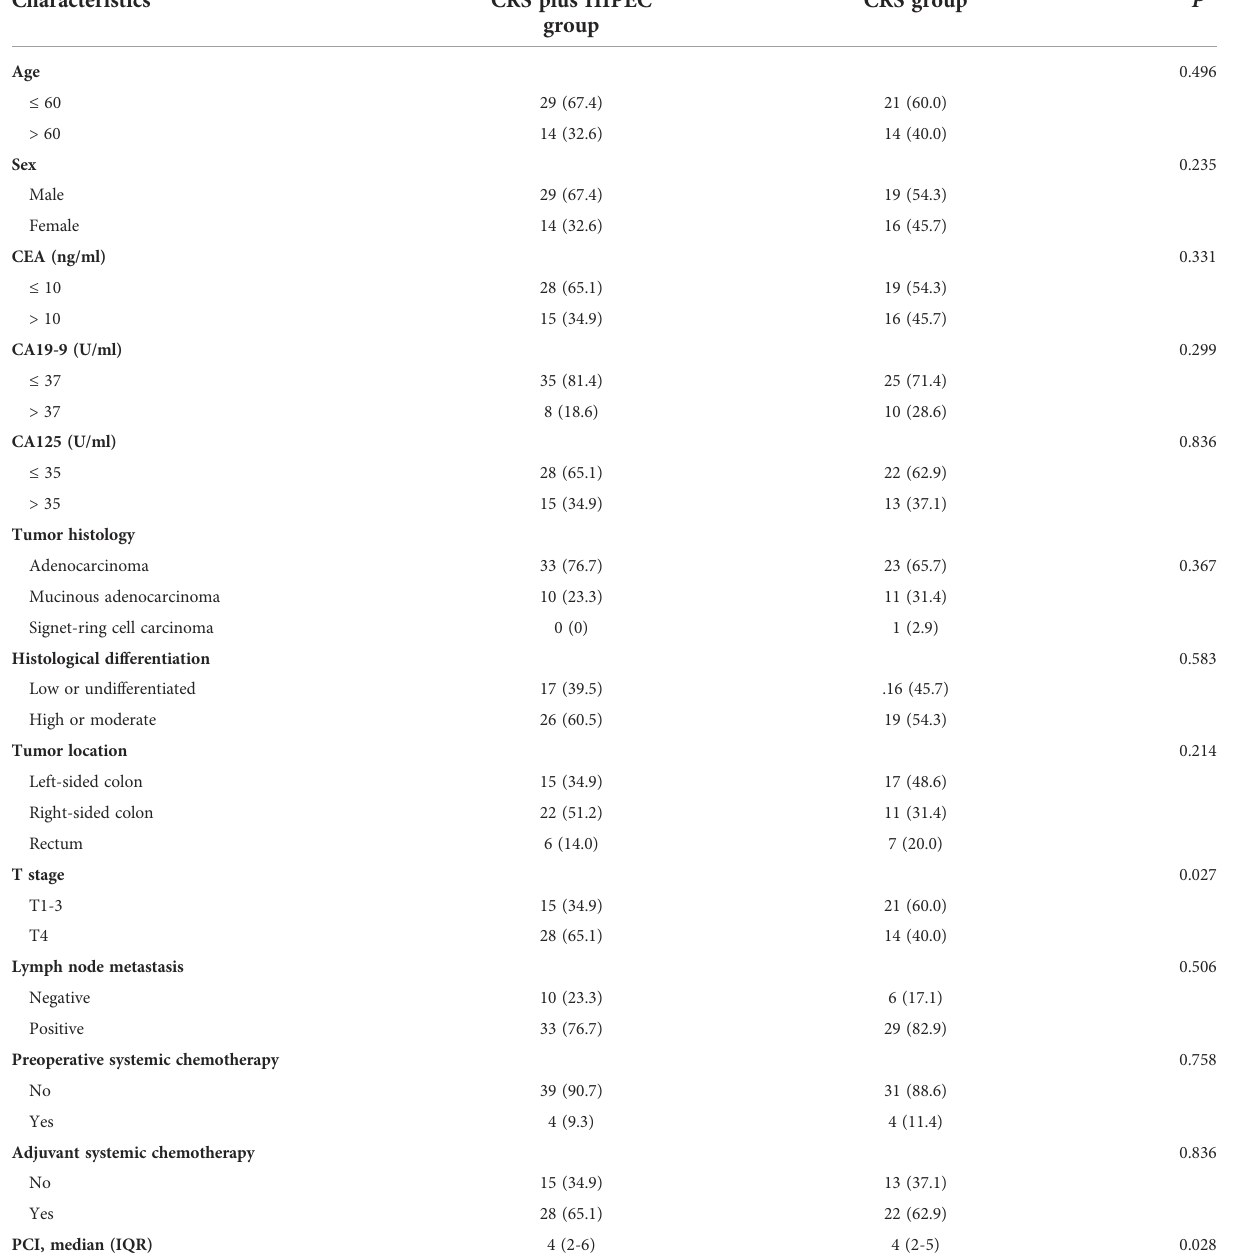
TABLE 1 Baseline characteristics in 78